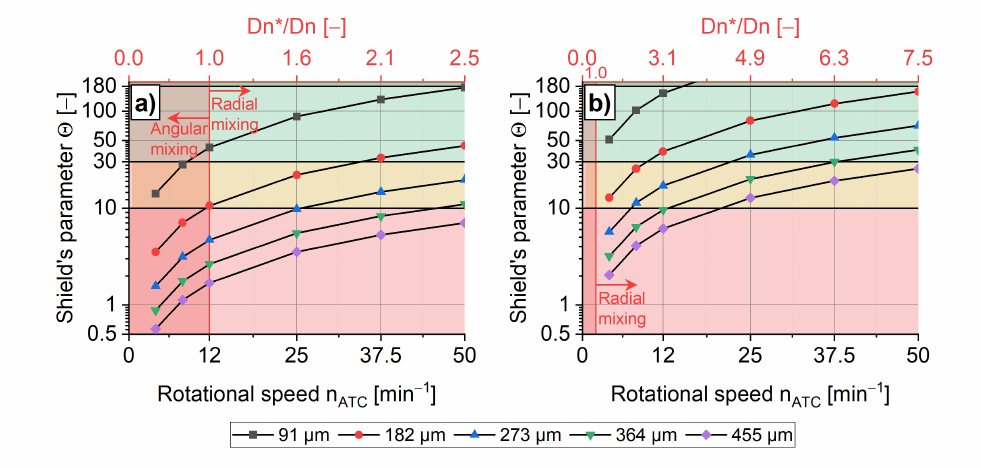
Figure 12. Calculated ratio of Modified Dean number Dn ∗ to Dean number Dn versus Shield ´ s parameter Θ in dependence of rotational speed n ATC and particle diameter d p according to Equations (17) and (18) for ( a ) d ct =50mm and ( b ) d ct =200mm; constant values: filling degree (cid:101) = 0.25, η f = 0.001 Pa s, ρ f = 1043 kg m − 3 and ρ p = 1420 kg m − 3